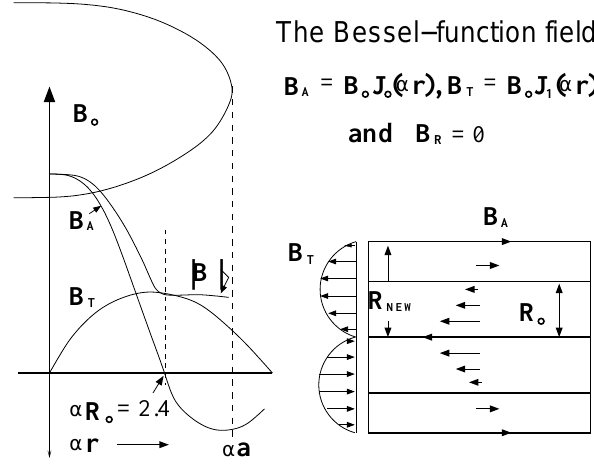
Fig. 6. (Left) The Bessel function curves resulting from the Lepping et al. (1990) model and (right) a sketch of the resulting vector fields. B A is the axial field, B T is the tangential field, and B R =0 is the radial field (with respect to the flux ropes axis). The B T field (shown in the plane of the figure on the right) is in actuality normal to it. Normally the MCs radius is determined to be R 0 , but occasionally is shown to be R NEW (see